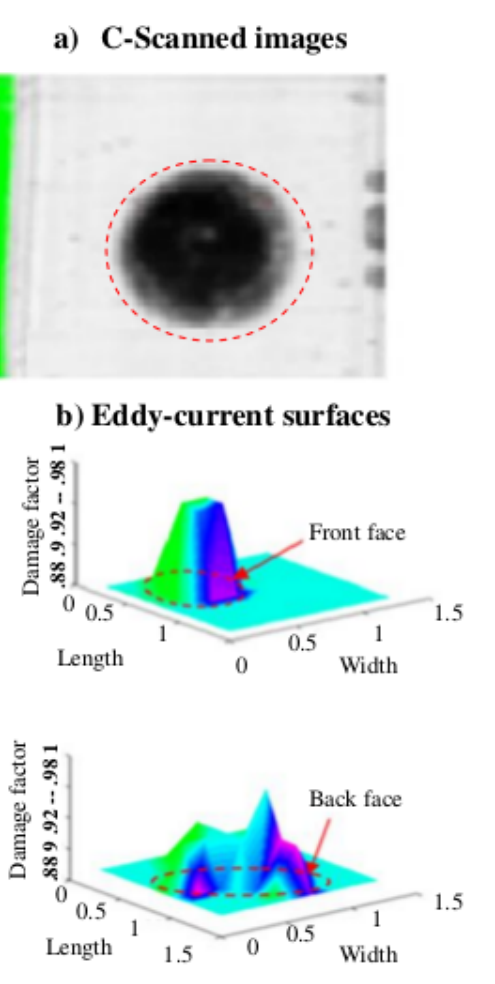
Figure 11: C-scan images and Eddy-current